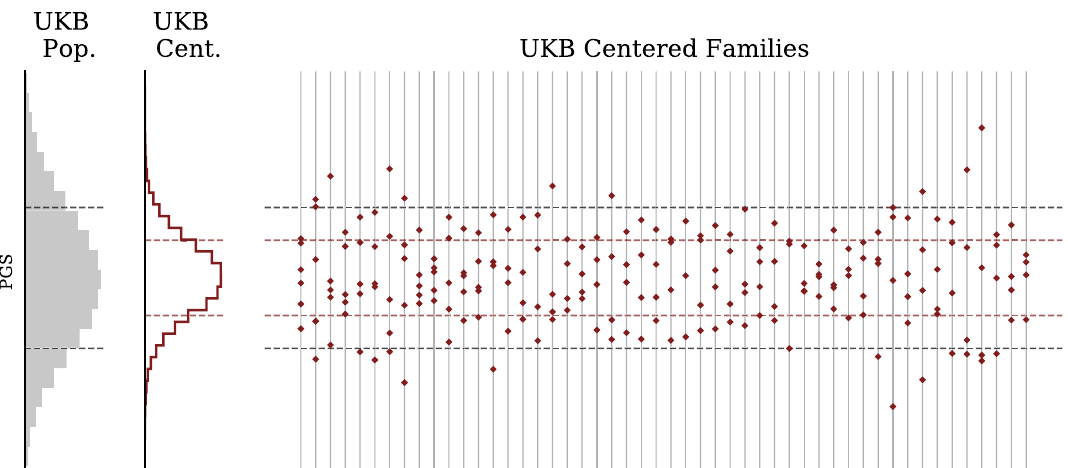
Figure 6. Type 2 Diabetes Polygenic Risk Score for UKB families (centered). Histogram on far left describes UKB general population. Middle histogram describes sibling scores after recentering relative to sibling average score (parental midpoint is generally not available). Sets of siblings organized by family are displayed on the right to indicate intra-family variation as compared to the general population. The sibling values have been centered within each family, unlike in the previous